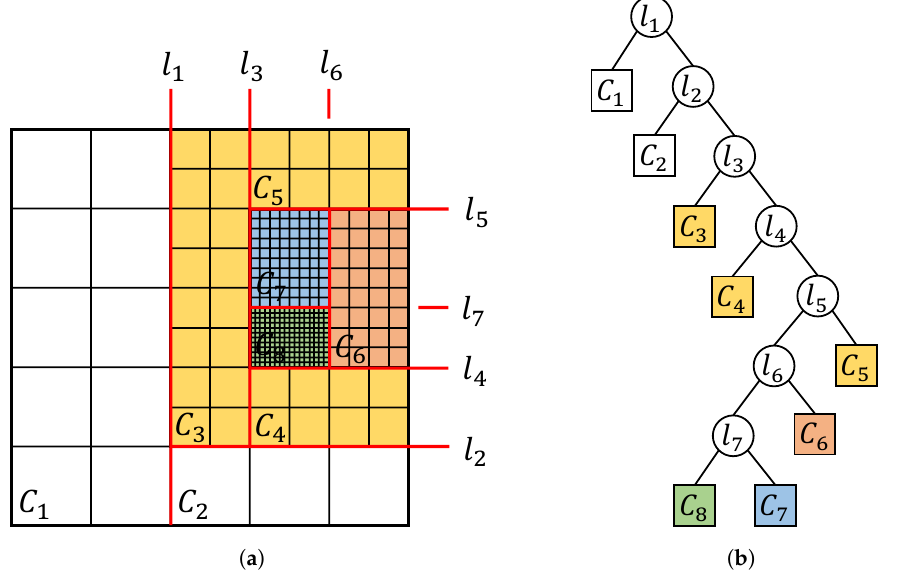
Figure 9. kd-tree representation of a two-dimensional hierarchical mesh. ( a ) Splitting lines and cells in the hierarchical mesh; ( b ) kd-tree representation. In ( a ), the domain is subdivided into homogeneous cells, with each belonging to only one hierarchical level, while in ( b ) the splitting lines and the cells are stored in the internal nodes and leaves of a kd-tree data structure,